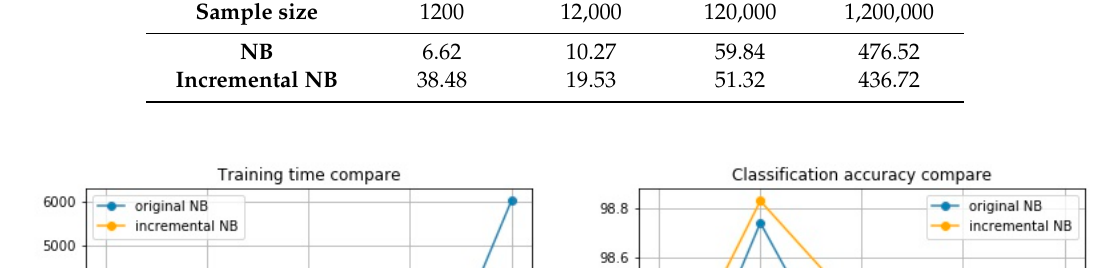
Figure 9. Result of scalable fault recognition.